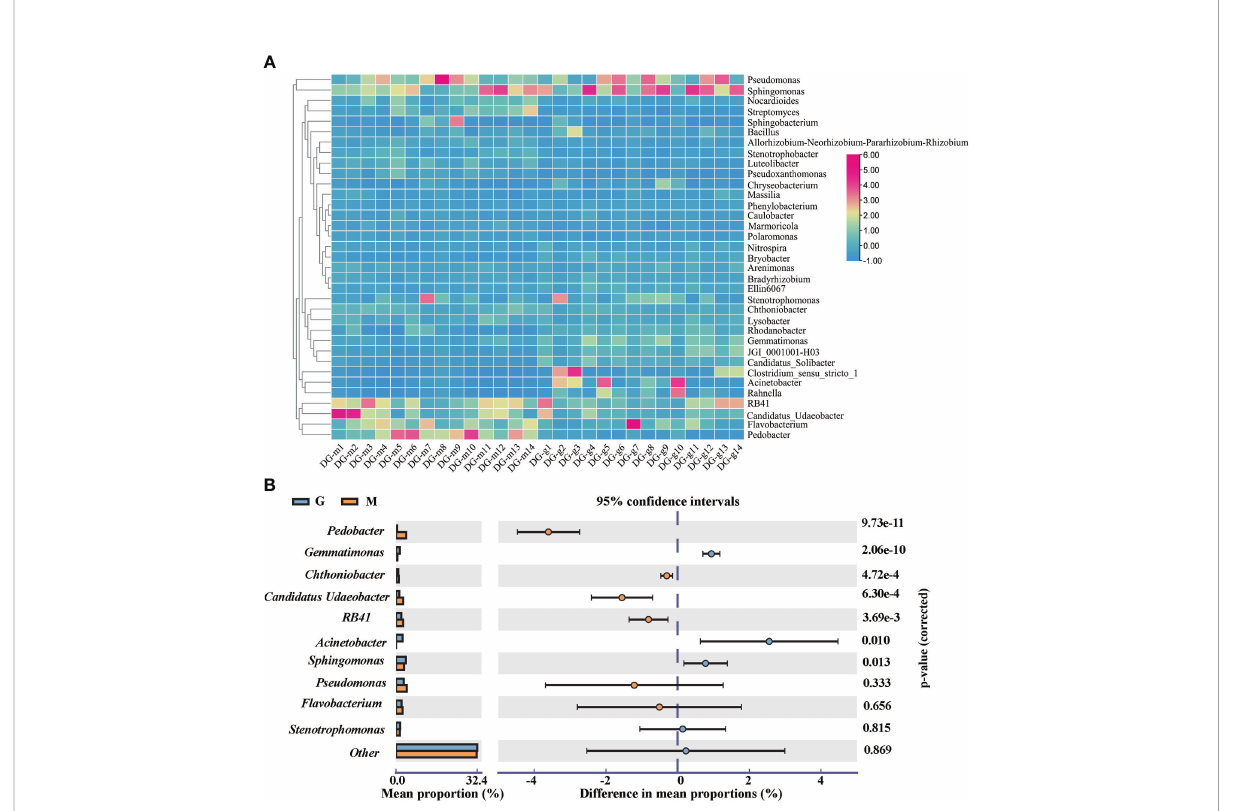
FIGURE 3 Heatmap of TOP 35 bacteria at the genus level between group M and G (A) . The top 10 genus with signi fi cant differences between group M and G (B)